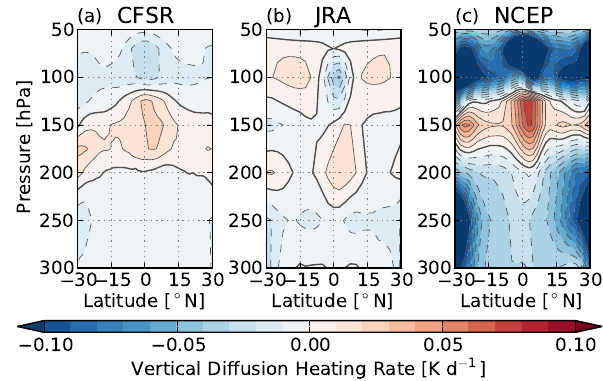
Fig. 6. Zonal mean heating due to parameterised turbulent mixing in (a) CFSR, (b) JRA, and (c)